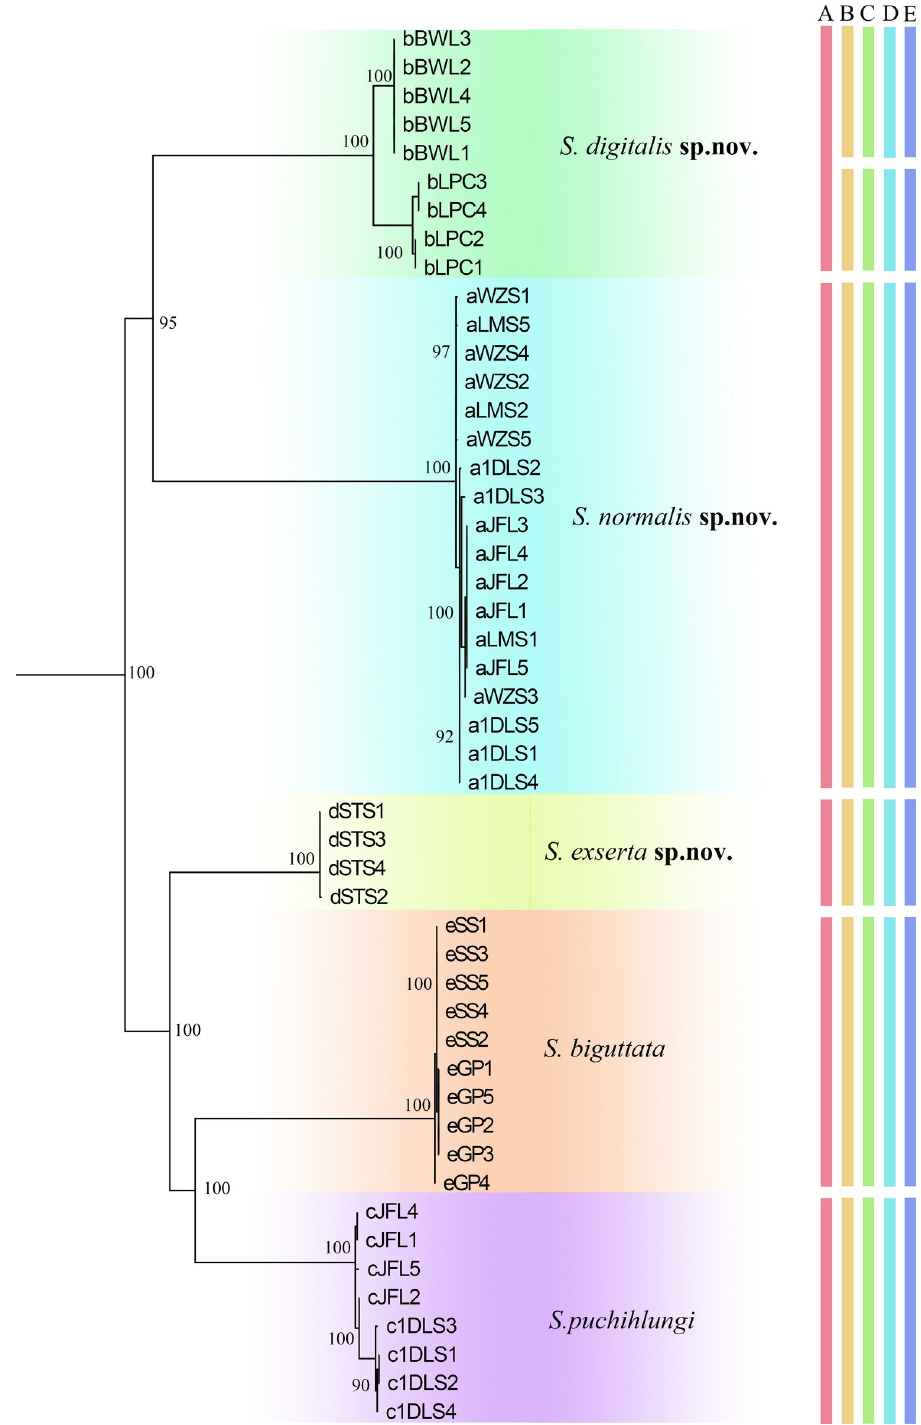
Fig 1. Maximum Likelihood (ML) gene tree with delimited MOTUs of the studied 5 Sigmella morphospecies. Numbers near node indicate the maximum-likelihood bootstrap values. The five morphospecies: S . schenklingi biguttata , S . digitalis sp. nov., S . normalis sp. nov., S . puchihlungi and S . exserta sp. nov. were highlighted by color corresponding to the clade. Letter indicates delimited MOTUs by different methods (A: Morphospecies, B: ABGD, C: GMYC, D: BINs, E: